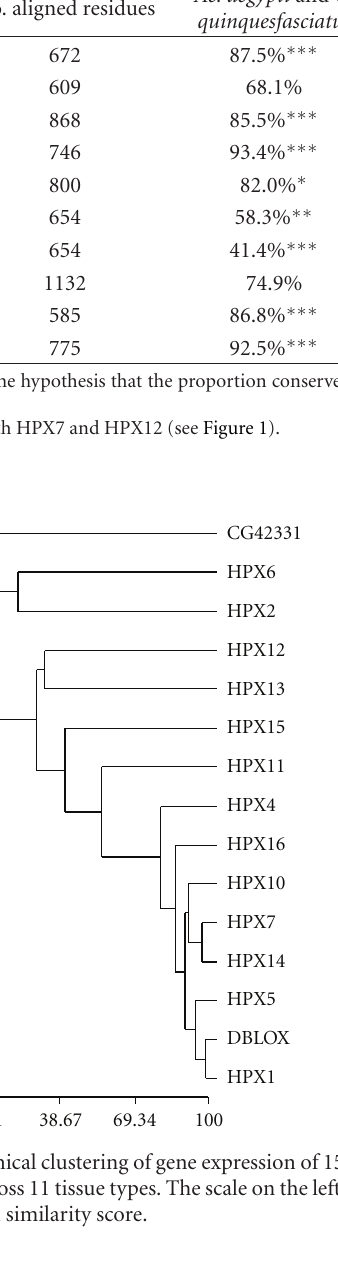
Table 1: Percentages of amino acid residues in heme peroxidases that are conserved among sets of dipteran taxa. Protein